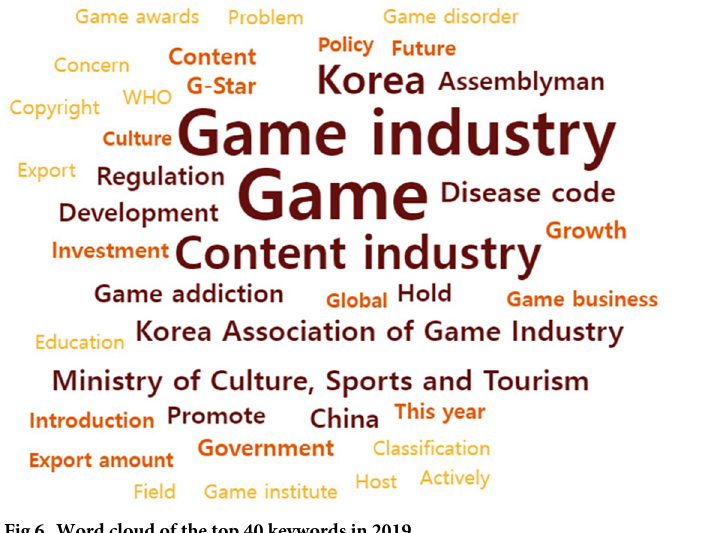
Fig 6. Word cloud of the top 40 keywords in